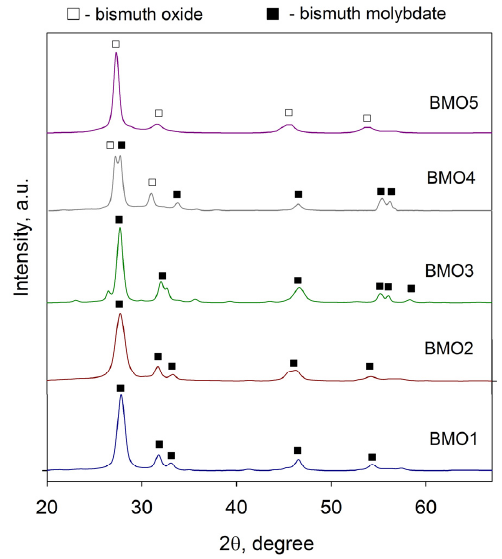
Figure 4. XRD patterns of bismuth molybdate coatings deposited onto glass substrates and annealed at 673 K.